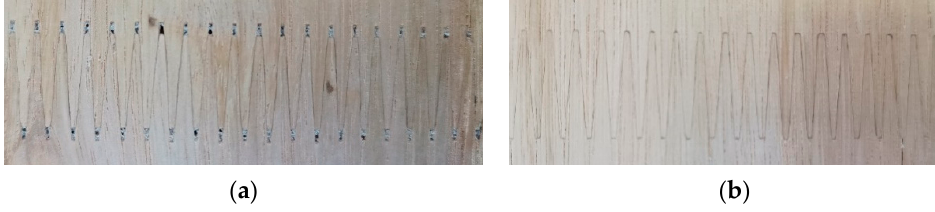
Figure 11. Finger joint appearances under different pressure values: ( a ) typical finger joint appearance under end pressure 1; ( b ) typical finger joint appearance under end pressure 2.